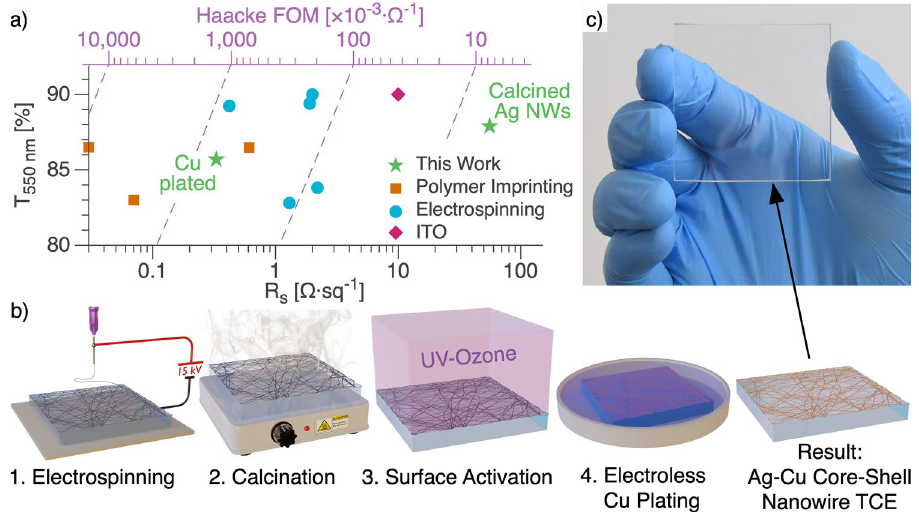
Figure 1. ( a ) Transmission at 550 nm (T 550 nm ) as a function of sheet resistance (R s ) plot showing the highest performance nanowire TCEs to date. TCEs based on polymer imprinting 22–24 , electrospinning 31–35 , and ITO 2 are included. The green stars are the highest FOM TCEs from this work for silver nanowires after calcination and silver nanowires with copper plating. The dashed purple lines are Haacke FOM isolines. Some transmittance values were recalculated from their original publications to include comparable substrates (Table S1). ( b ) Schematic of the TCE fabrication process. 1. An electrospinner deposits polymer nanowires that contain reactive silver ink onto a glass substrate. 2. A hotplate at 300 °C calcines the nanowires for 30 s to vaporize the polymer and reduce the silver precursor. 3. A UV-ozone treatment activates the silver nanowire surface for electroless copper deposition. 4. Electroless copper deposition creates a copper shell around the silver nanowires to fuse the junctions. A core–shell silver–copper nanowire network remains on the substrate. ( c ) Photograph showing real- world transparency and color neutrality of nanowire